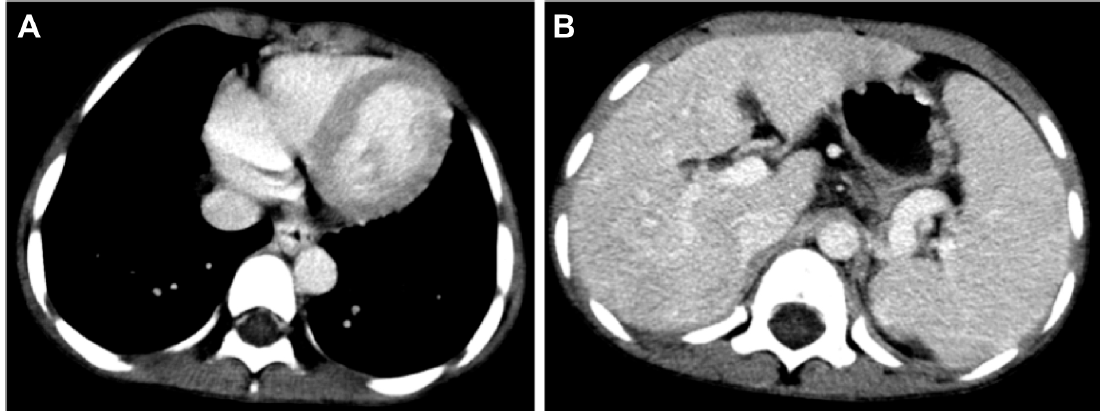
Figure 5. Enhanced computerized tomography scans showing esophageal ( A ) and gastric ( B ) varices. Int. J. Mol. Sci. 2019 , 20 , x FOR PEER REVIEW